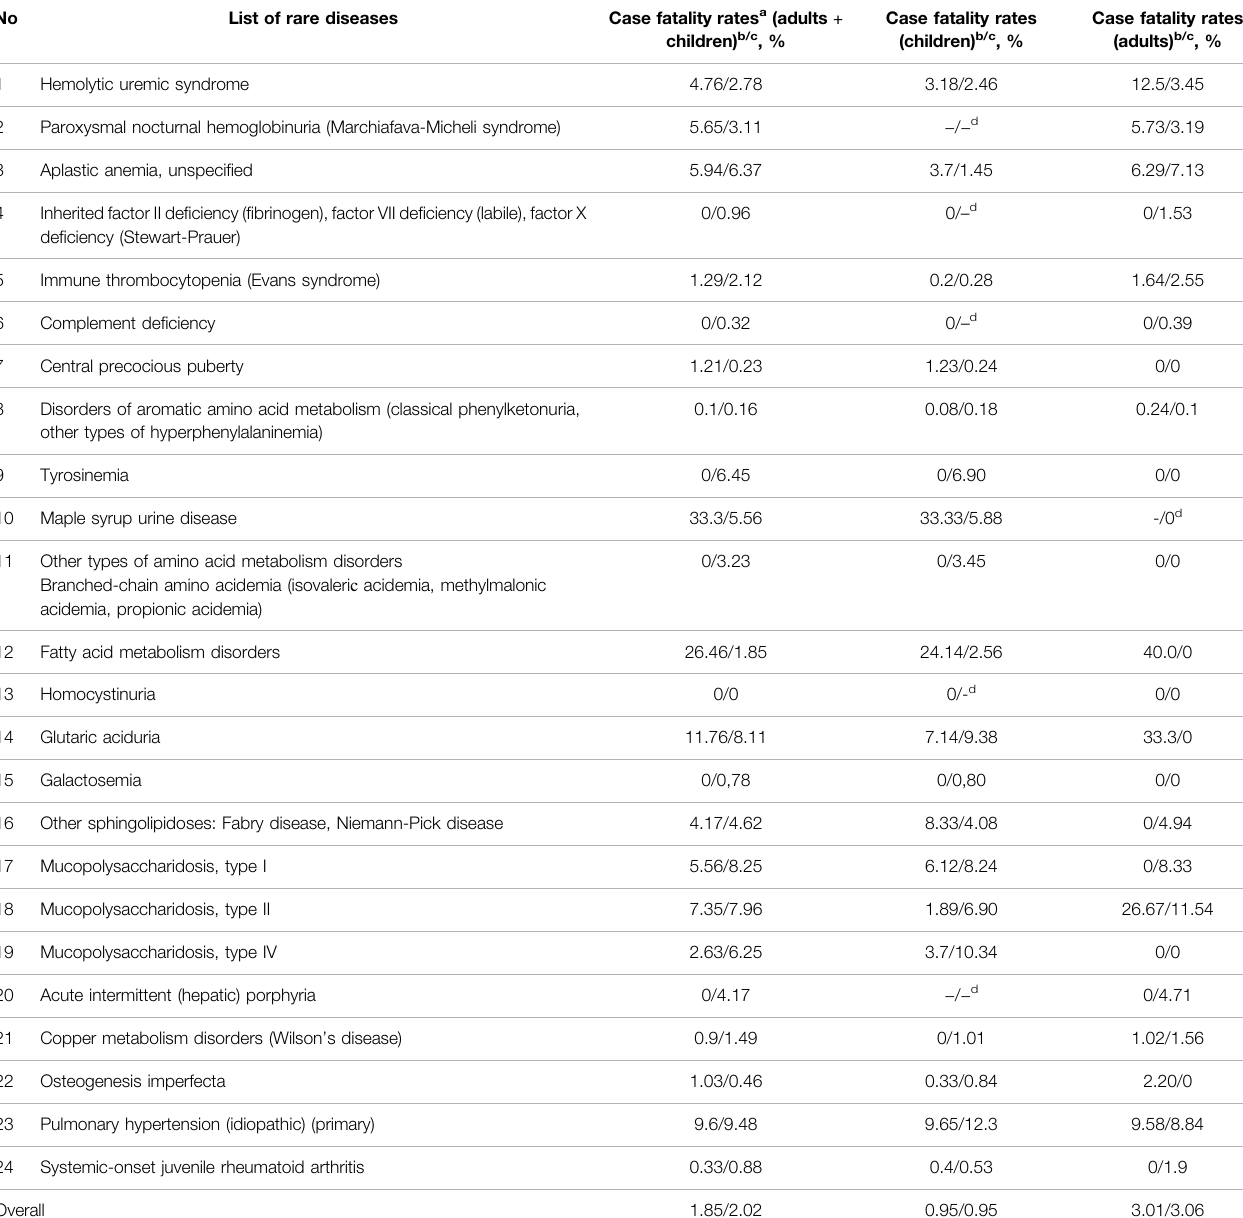
TABLE 5 | The case fatality rates for different diseases from the “ The regional list of patients with rare diseases ” in 2013 – 2914 and 2016 – 2017.